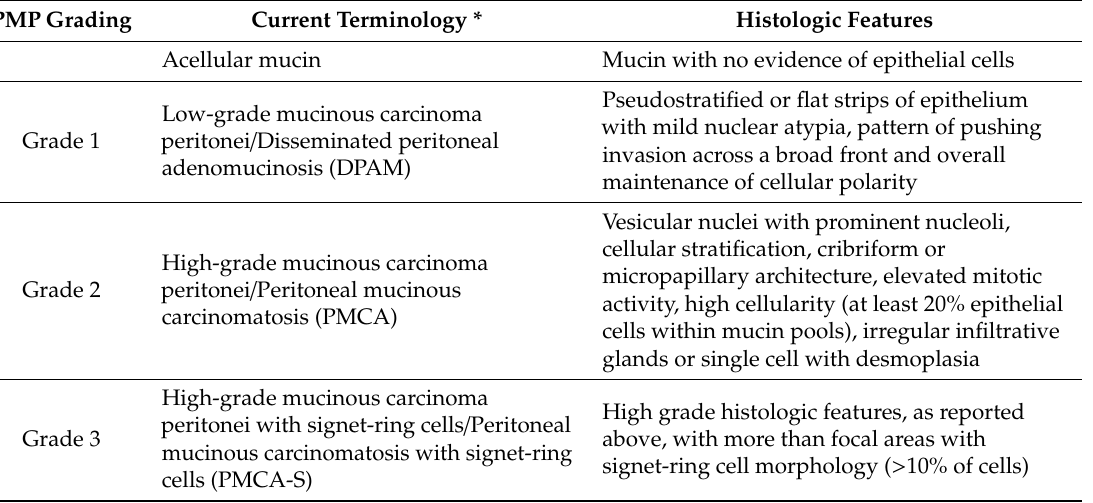
Table 1. Classification of Pseudomyxoma Peritonei